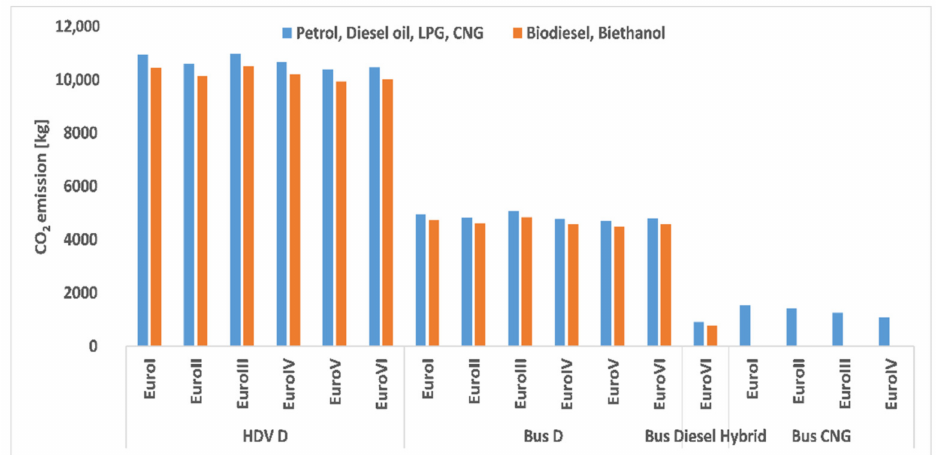
Figure 6. Comparison of CO 2 emissions from HDVs and buses depending on Euro standard and fuel type.